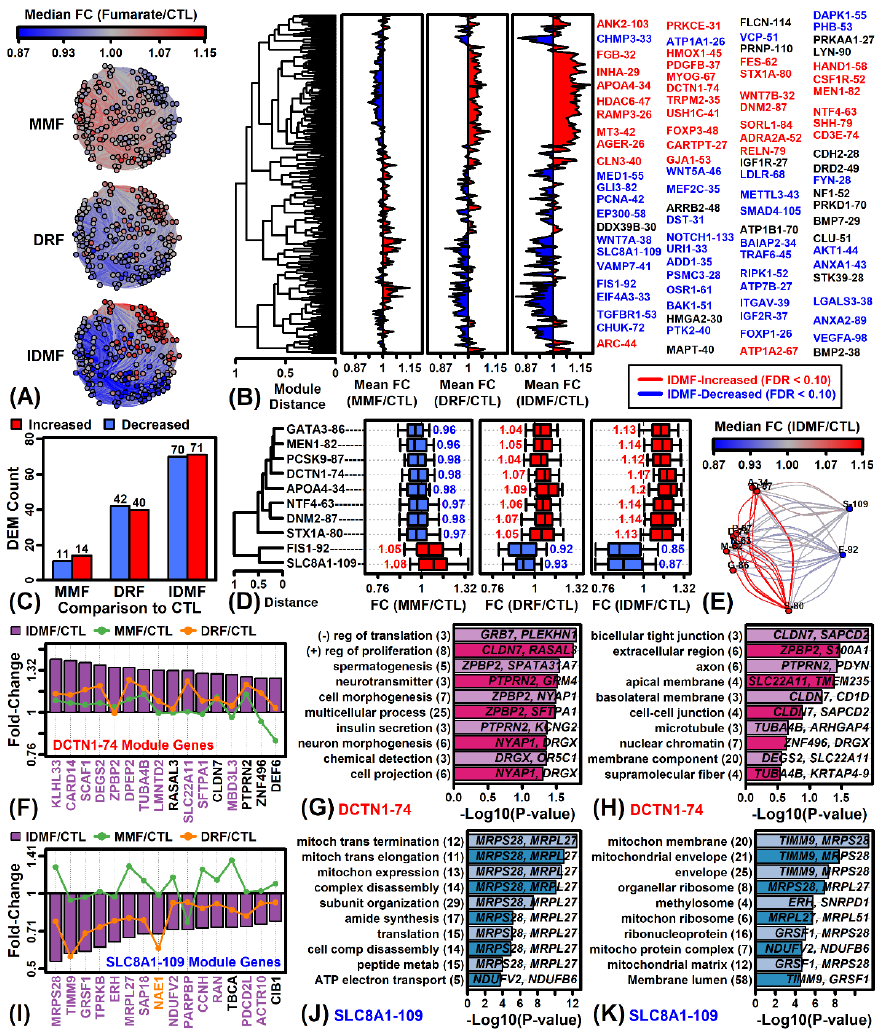
Figure 3. Gene expression module analysis. ( A ) Module co-expression networks. Each vertex represents one of 234 modules. Connections are drawn between modules for which medoids are correlated ( r s ≥ 0.80). Vertex color reflects the average FC of module genes. Edge color reflects the average FC of the two modules joined. ( B ) Module cluster analysis. The 234 module medoids were clustered based upon the Euclidean distance (normalized to the [0, 1] interval). Average FC for each module is shown and module IDs are listed (right margin). ( C ) Number of differentially expressed modules (DEMs) for each comparison (MMF vs. CTL, DRF cv. CTL, IDMF vs. CTL). ( D ) IDMF-responsive modules (cluster analysis). The 10 modules most strongly altered by IDMF are shown. Cluster analysis was performed using Euclidean distance (normalized to the [0, 1] interval). Boxplots outline the middle 50% of FC estimates for each module (whiskers: 10th to 90th percentiles). ( E ) IDMF-responsive modules (network). The 10 modules from ( D ) are shown (vertex labels are abbreviated). Network parameters and color-coding are as described for part ( A ) above. ( F ) Module DCTN1-74 genes. The 16 genes most strongly increased by IDMF are shown (i.e., lowest p -values). ( G ) GO BP terms enriched among module DCTN1-74 genes. ( H ) GO CC terms enriched among module DCTN1-74 genes. ( I ) Module SLC8A1-109 genes. The 16 genes most strongly decreased by IDMF are shown (i.e., lowest p -values). ( J ) GO BP terms enriched among module SLC8A1-109 genes. ( K ) GO CC terms enriched among module SLC8A1-109 genes. In ( G , H , J , K ), the number of genes associated with each term is listed in parentheses (left margin) and example genes are listed within the figure.